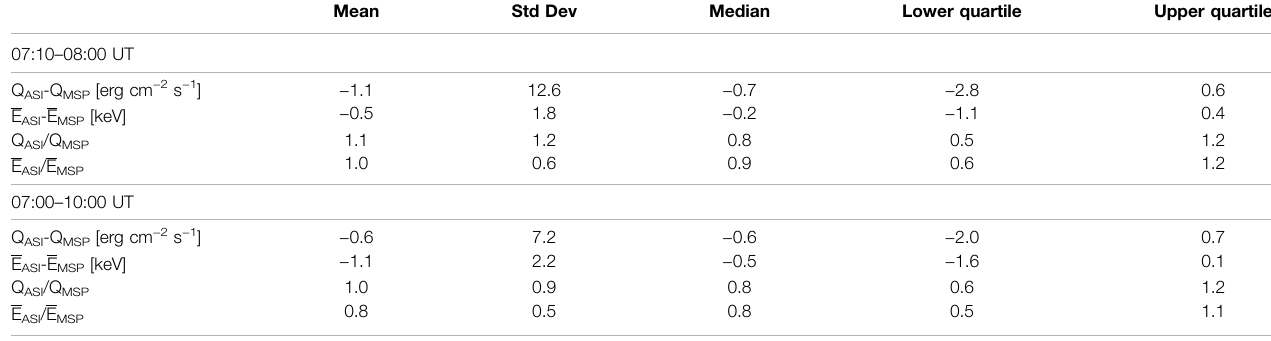
TABLE1| Themean,standarddeviation,median,andupperandlowerquartilesoftheratiosandthedifferencesbetweenASI-andMSP-determinedenergy fl ux(Q)andaverage energy(E).The fi rstfourlinesarefortheFigure4timewindow(07:10 – 08:00UT).Thebottomfourlinesarefor thefulltimewindowusedforthecalibration(07:00 – 10:00UT). Mean Std Dev Median Lower quartile